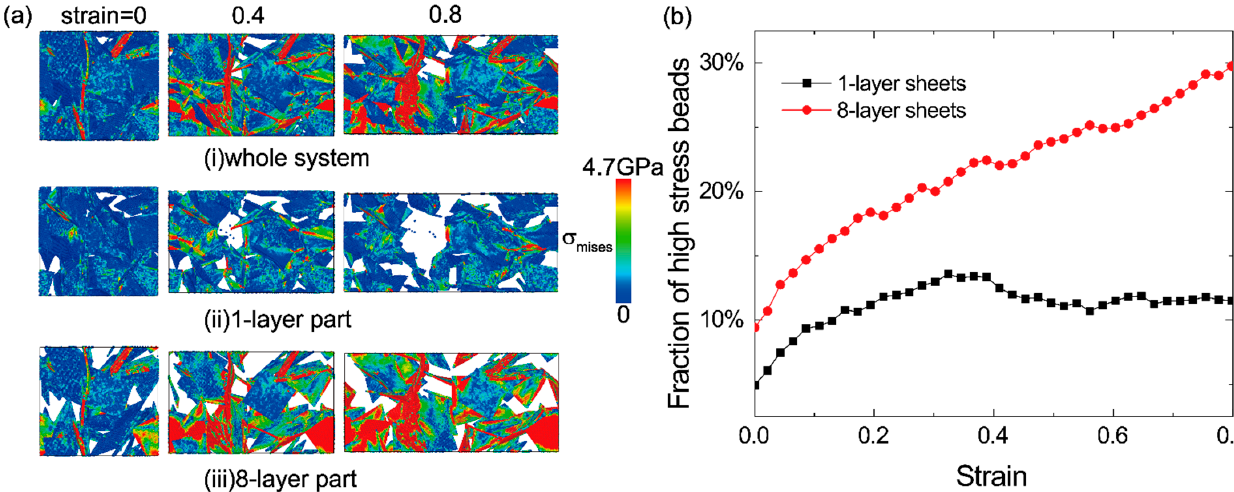
Figure 4. ( a-i ) The distribution of the local von-Mises stress of the whole GrF system with v = 50%; for a direct comparison of the stress distribution in 1-layer sheets and 8-layer sheets, the two parts are displayed separately in ( a-ii ) and ( a-iii ); ( b ) The comparison of the ratio of high stress beads in 1-layer sheets and 8-layer sheets in the GrF with v = 50%.